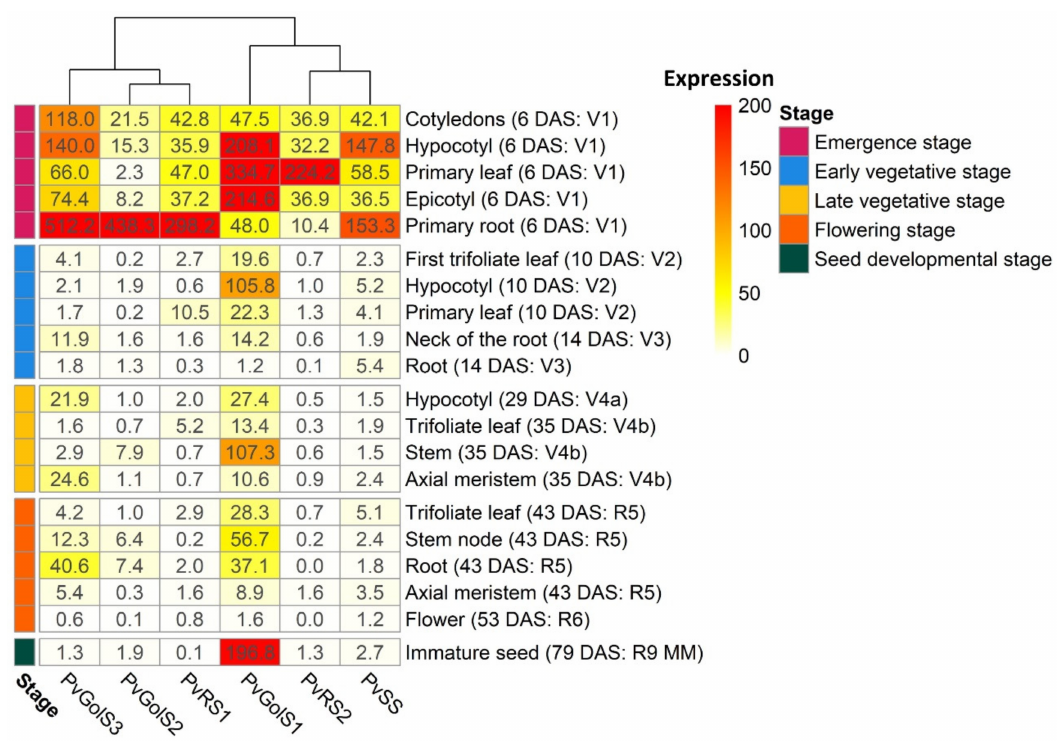
Figure 4. Heatmap of the normalized expression values, presented in transcripts per million (TPM), of the galactinol synthase ( PvGolS1-3 ), raffinose synthase ( PvRS1-2 ) and stachyose synthase ( PvSS ) genes in various plant tissues during different developmental stages in P. vulgaris cv. BAT93 (SRP030614). The rows represent plant tissues in five different developmental stages: emergence stage, early vegetative stage, late vegetative stage, flowering stage and seed developmental stage. More detailed information of the exact growth stage of the tissues can be found after the tissues name between brackets, indicated in days after sowing (DAS) and with growth stage abbreviations (V1: emergence stage; V2: primary leaves stage; V3: first trifoliate leaf stage; V4: third trifoliate leaf stage; R5: preflowering stage; R6: flowering stage; R9: maturity stage; MM: mid maturation stage of the seed) adapted from Vlasova et al. [53]. The columns represent the different genes and their expression levels, represented with a color gradient in which white indicated no expression (0 TPM) and red the highest expression (200+ TPM). Hierarchical clustering was performed between the columns to obtain gene